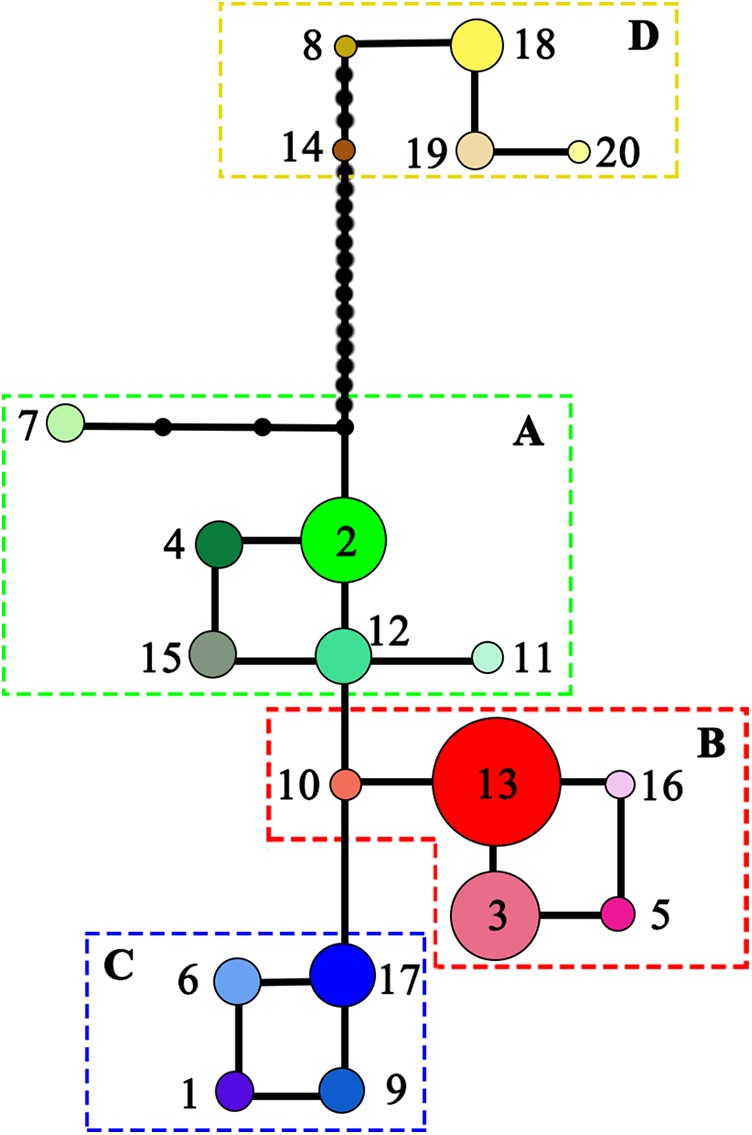
Median-joining network of the 20 haplotypes detected in Liriodendron
chinense (clades A–C) and Liriodendron tulipifera (clade D).Black dots indicated the number of mutational steps.